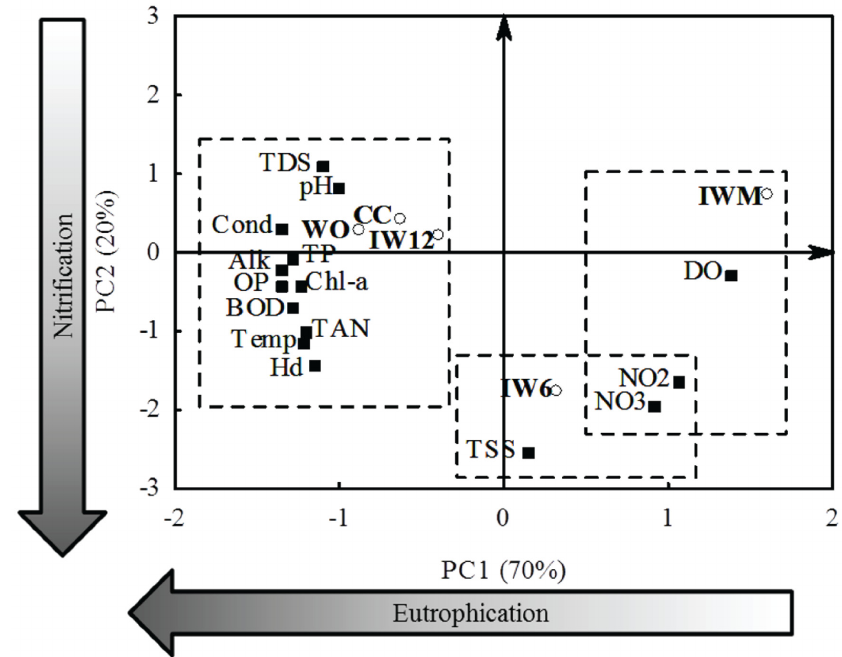
Figure 3. Interpolation of eigenvalues from the matrix of water variables. First two axis from the principal component analysis (PCA). Open circles = sites, filled squares = water variables. CC= close to cages in the open-pond, WO= water outlet, IW12= water inlet receiving effluents from 12 fishponds, IW6= water inlet receiving effluents from 6 fishponds, IWM= water inlet opening into a macrophyte bed, Alk= alkalinity, BOD= 5-day biochemical oxygen demand, Chl-a= chlorophyll-a, Cond= conductivity, DO= dissolved oxygen, Hd= hardness, NO2= nitrite, NO3= nitrate, OP= orthophosphate, TAN= total ammonia nitrogen, TDS= total dissolved solids, Temp = temperature, TP= total phosphorus, TSS= total suspended